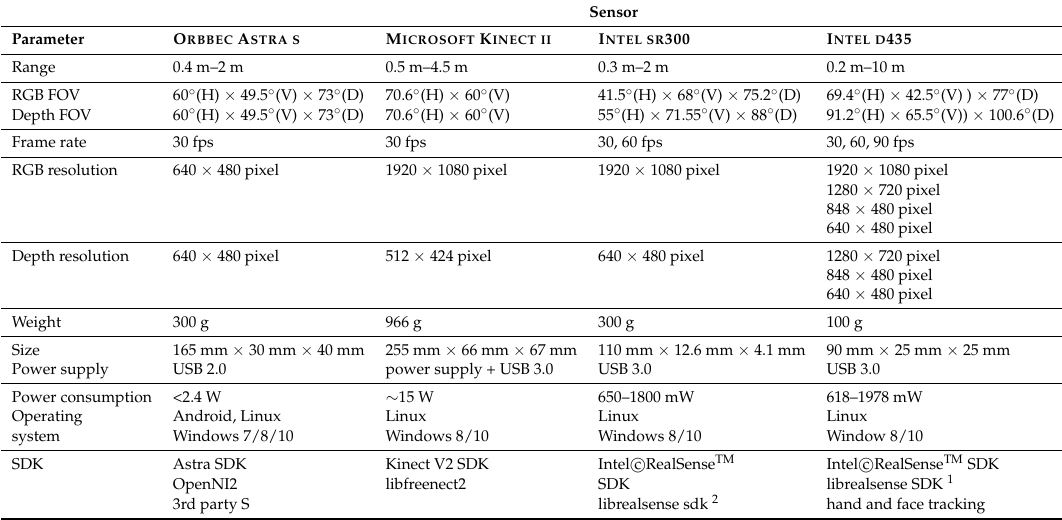
Figure 1. The setup of the four sensors used in the experiment. Kinect II at the bottom, the Astra Pro on the left, the SR300 on the right, and the gray D435 on top of the SR300. Table 1. Properties of the RGB-D sensors used in our